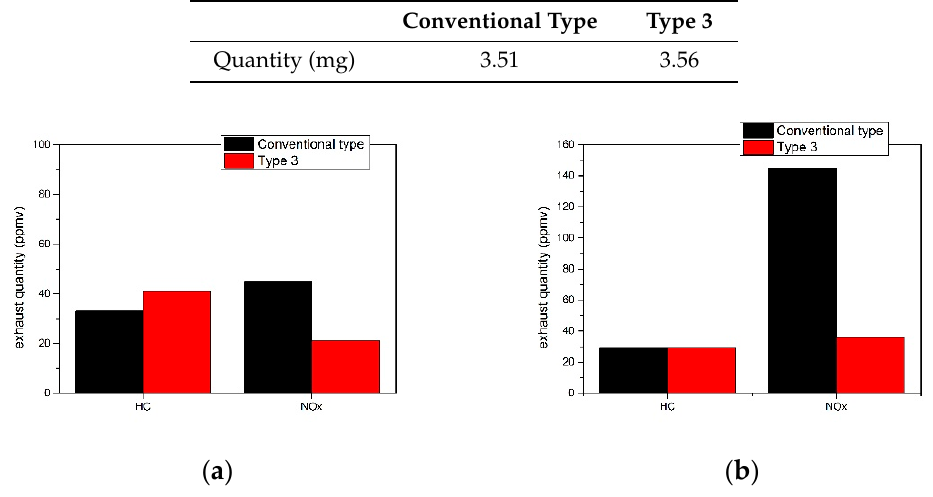
Table 10. Comparison of injection quantity between conventional type and Type 3 DPI.